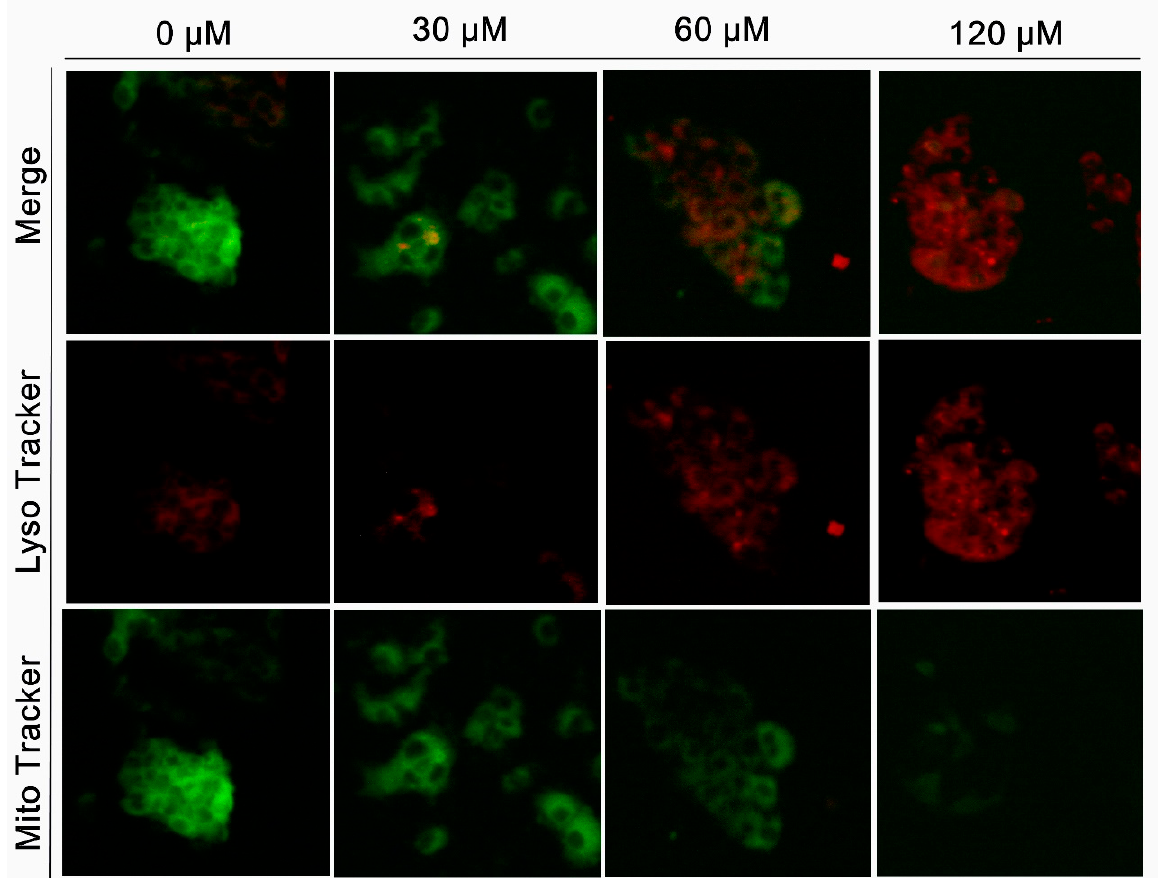
Figure 7. Analysis of the quantity of mitochondria in HepG2 cells after treatment with CHL. The change trends of Mito-tracker and Lyso-tracker’s fluorescence intensity were detected by epifluorescence (200×).